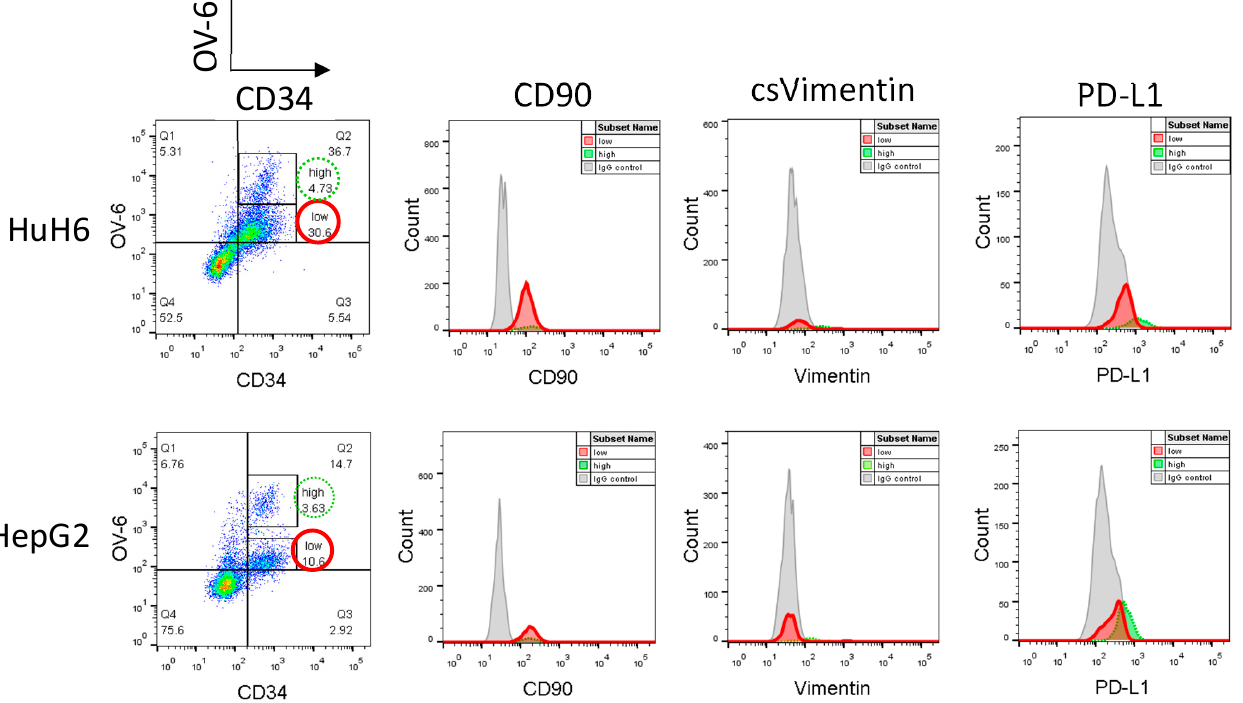
Figure 4. CD34 +/low OV-6 low cells express CD90 but not csVimentin or PD-L1. HuH6 cells were treated with 100 nM decitabine and 2 µ g/mL cisplatin and HepG2 cells with 250 nM decitabine and 3 µ g/mL cisplatin for 72 h and measured for CD34, CD90, csVimentin and PD-L1 expression and for OV-6 binding using flow cytometry. The cells were first gated into CD34 +/high OV-6 high (high, green line) and CD34 +/low OV-6 low (low, red line) cells and subsequently analyzed for CD90, csVimentin or PD-L1 expression. These are representative results of at least 5 experiments.